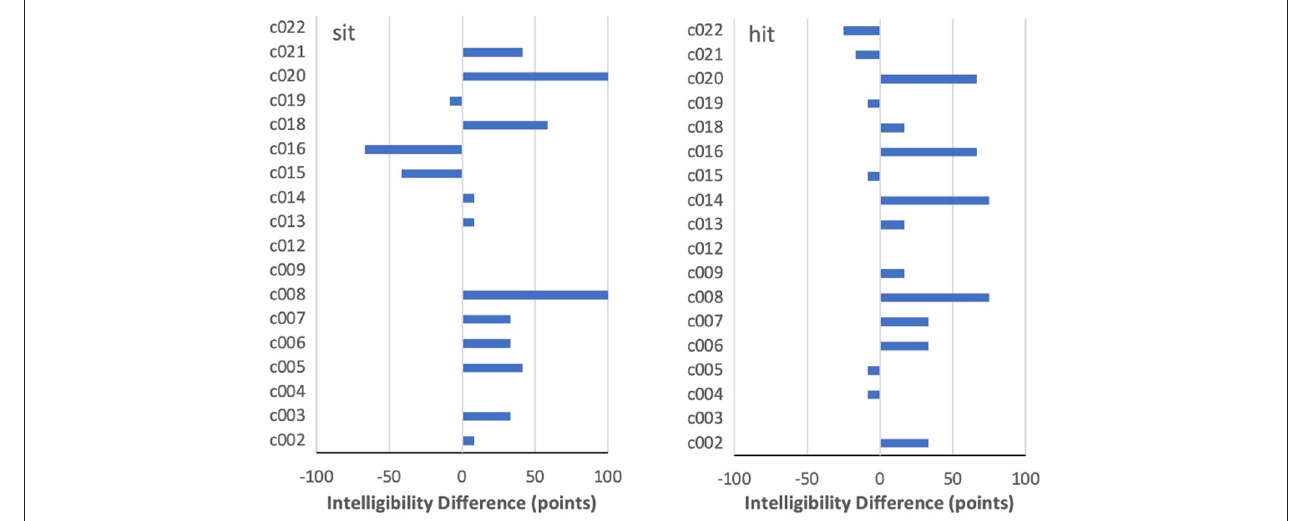
FIGURE 4 | By-speaker differences between mean intelligibility scores on the two tasks for sit and hit